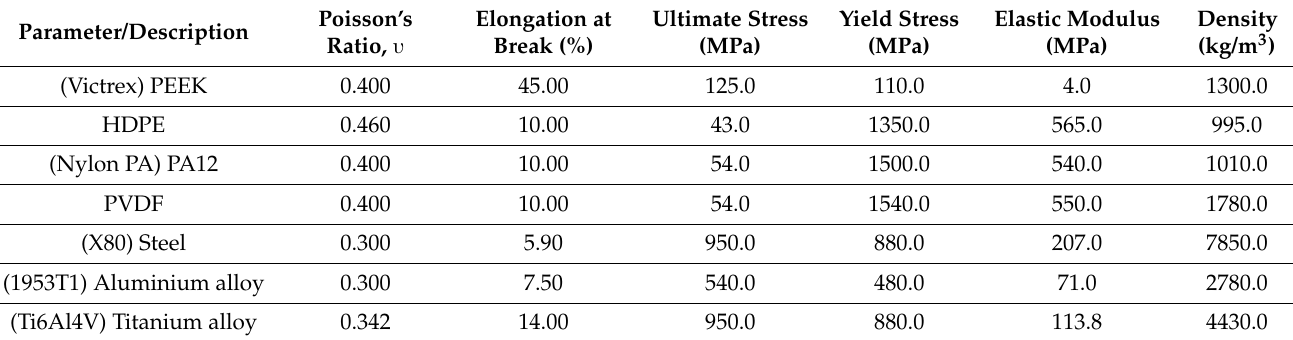
Table 4. Selected design, stack-up sequences, material configurations, and CPR’s composite lamina orientations.